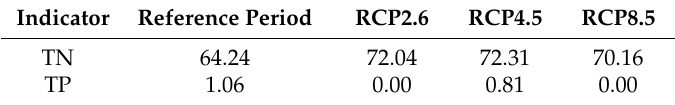
Table 10. The incidence of water pollution (%) under the Future Climate Change scenario.